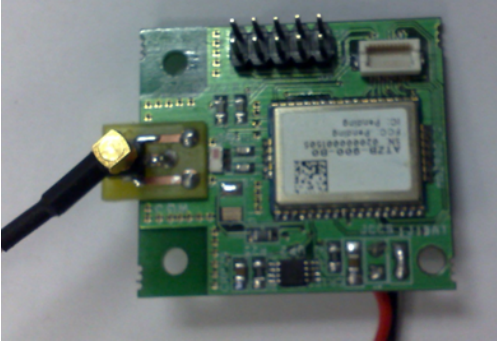
Figure 6. WorldSensing G3 mote used in the